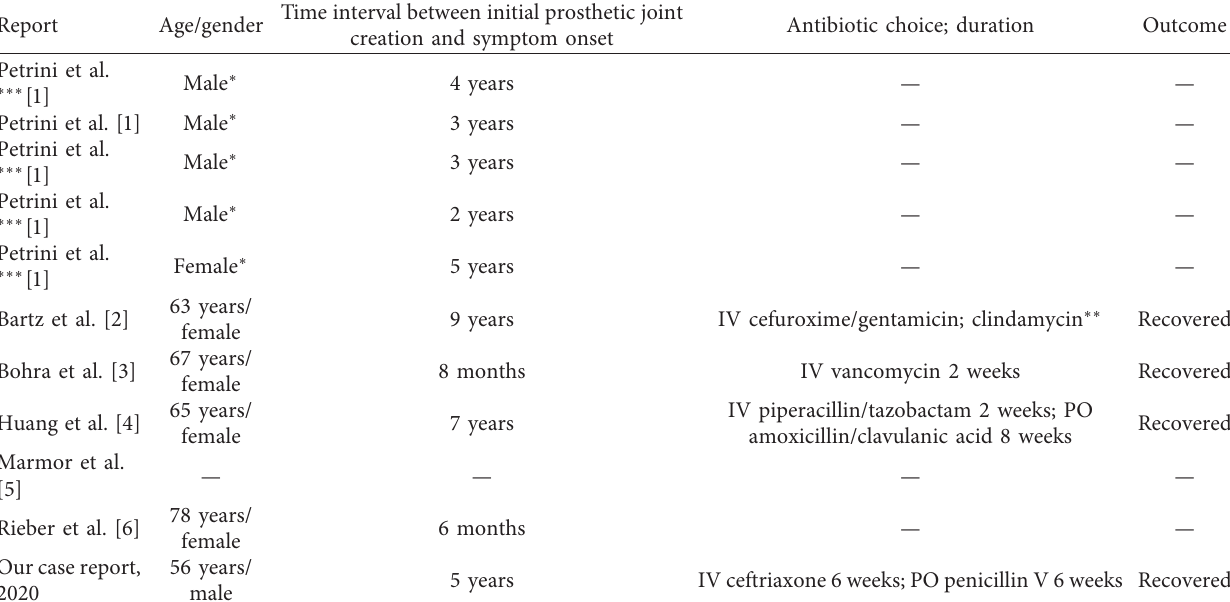
Table 1: Summary of reported cases of Micromonas micros PJI in the hip